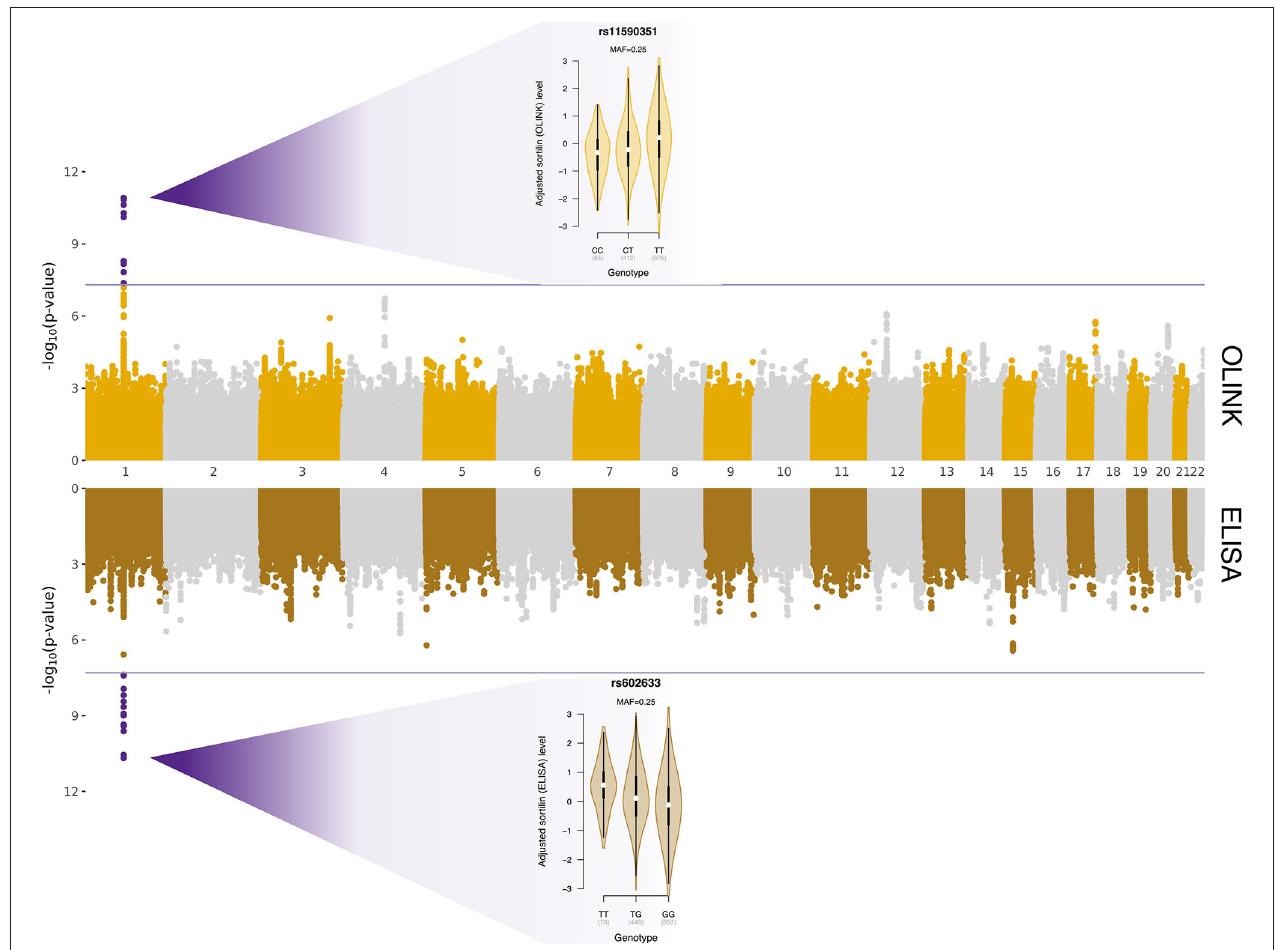
FIGURE 2 | Protein quantitative trait loci for variation in sortilin level quantified with OLINK (top panel) and ELISA (bottom panel). The x -axis is chromosomal position, and the y -axes show the negative logarithm base-10 to the P -values from regression of circulating sortilin level on 4,658,994 autosomal genetic variants. The horizontal lines indicate the genome-wide significant threshold of 5 × 10 − 8 , and points highlighted in purple are genetic variants surpassing this threshold. The two violin plots show the association between adjusted sortilin level and genotypes for the two identified cis